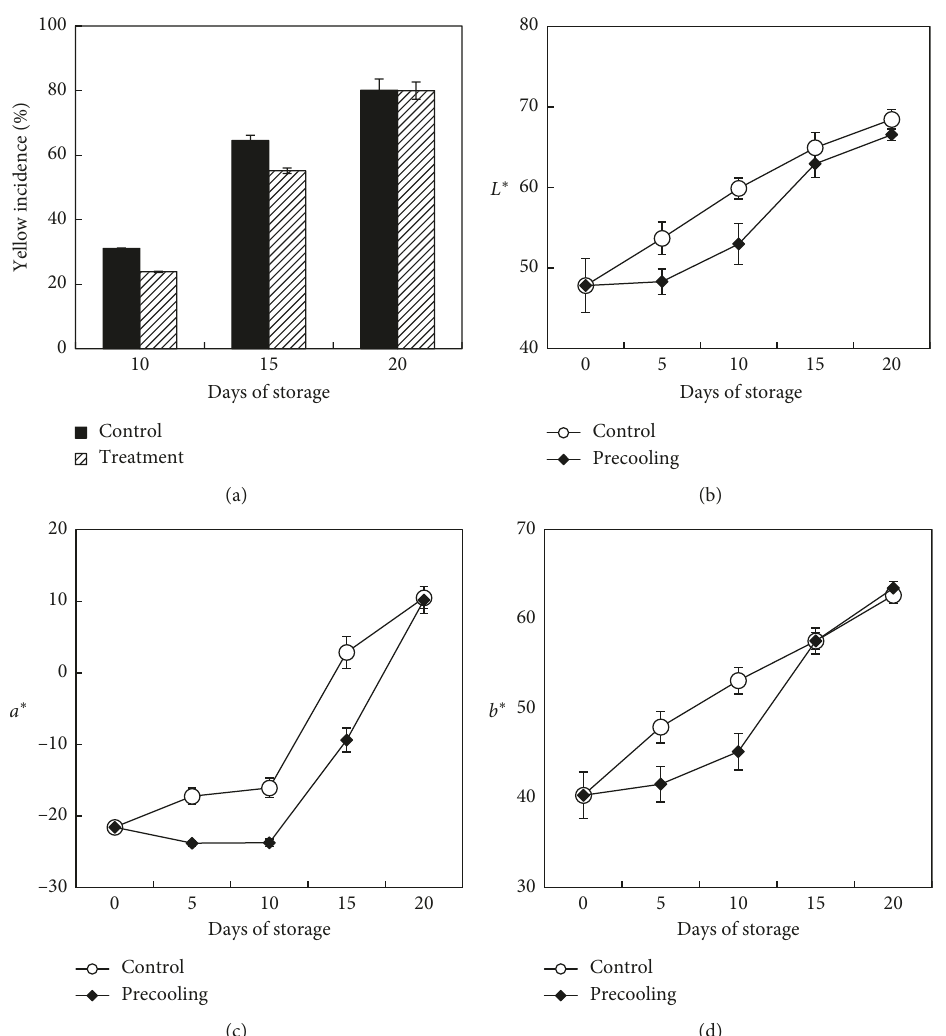
F IGURE 2: Effects of forced air precooling treatment on the (a) yellow index, (b)